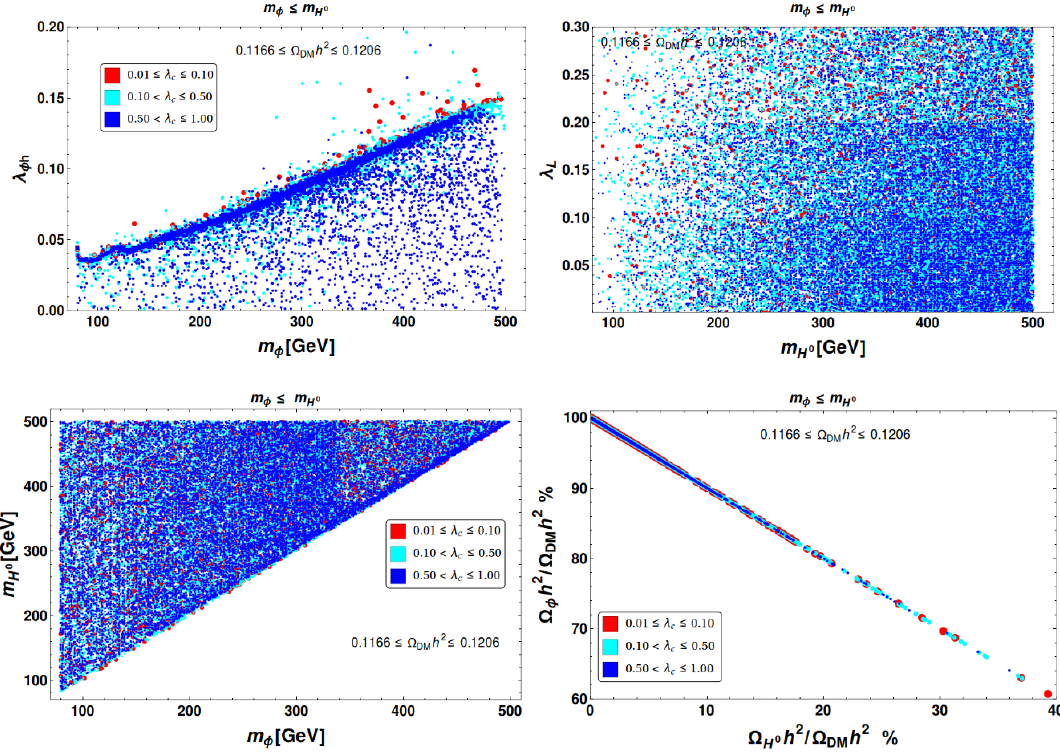
Figure 15 . Relic Density allowed parameter space is shown in m (cid:30) (cid:0) (cid:21) (cid:30)h plane (top left), m plane (top right), m (cid:30) (cid:0) m (bottom right) for the mass hierarchy m (cid:30) (cid:20) m